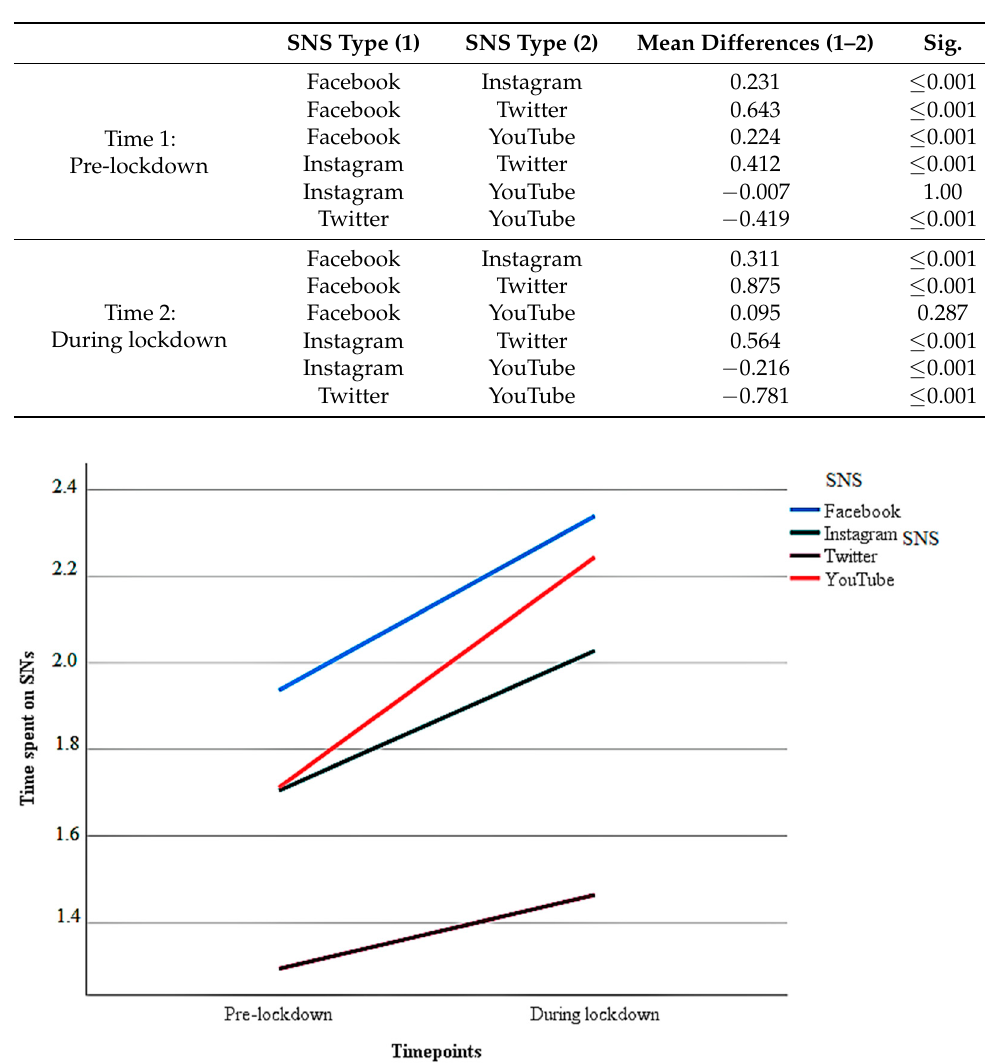
Figure 1. Graph of SNS Usage Time Depending on the Type of SNS Used at the Pre-Lockdown Time and During Lockdown.